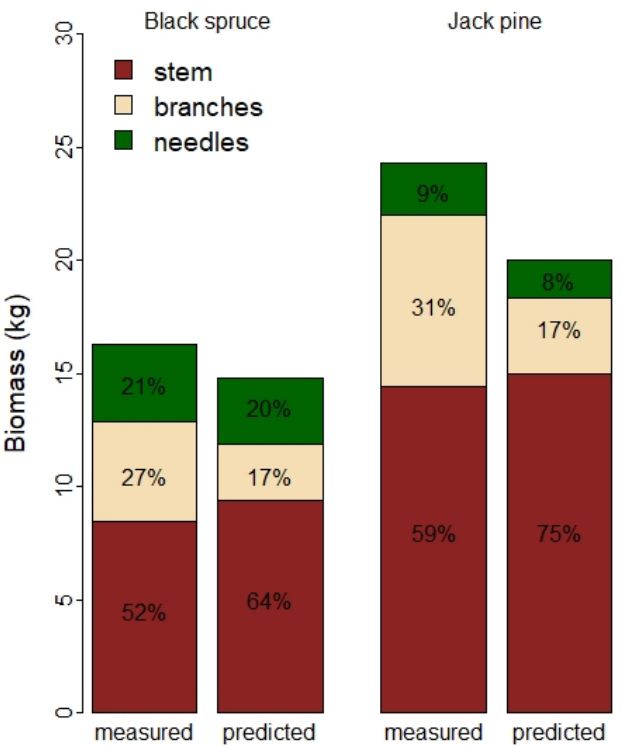
Figure 2. Average biomass allocation to stems, branches, and needles for black spruce ( n = 96) and jack pine ( n = 50) trees (height >1.3 m) sampled in open woodlands of Quebec (measured) vs. predicted allocation by using the allometric equations developed by Lambert et al. (2005).